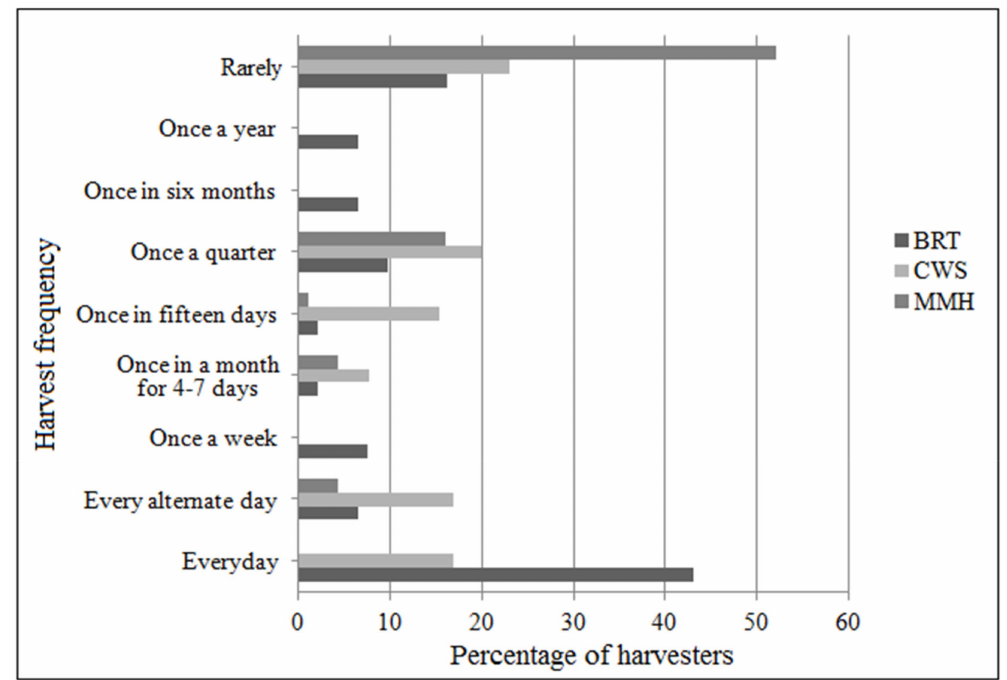
Figure 2. Frequency of B. serrata harvest at the three study sites.